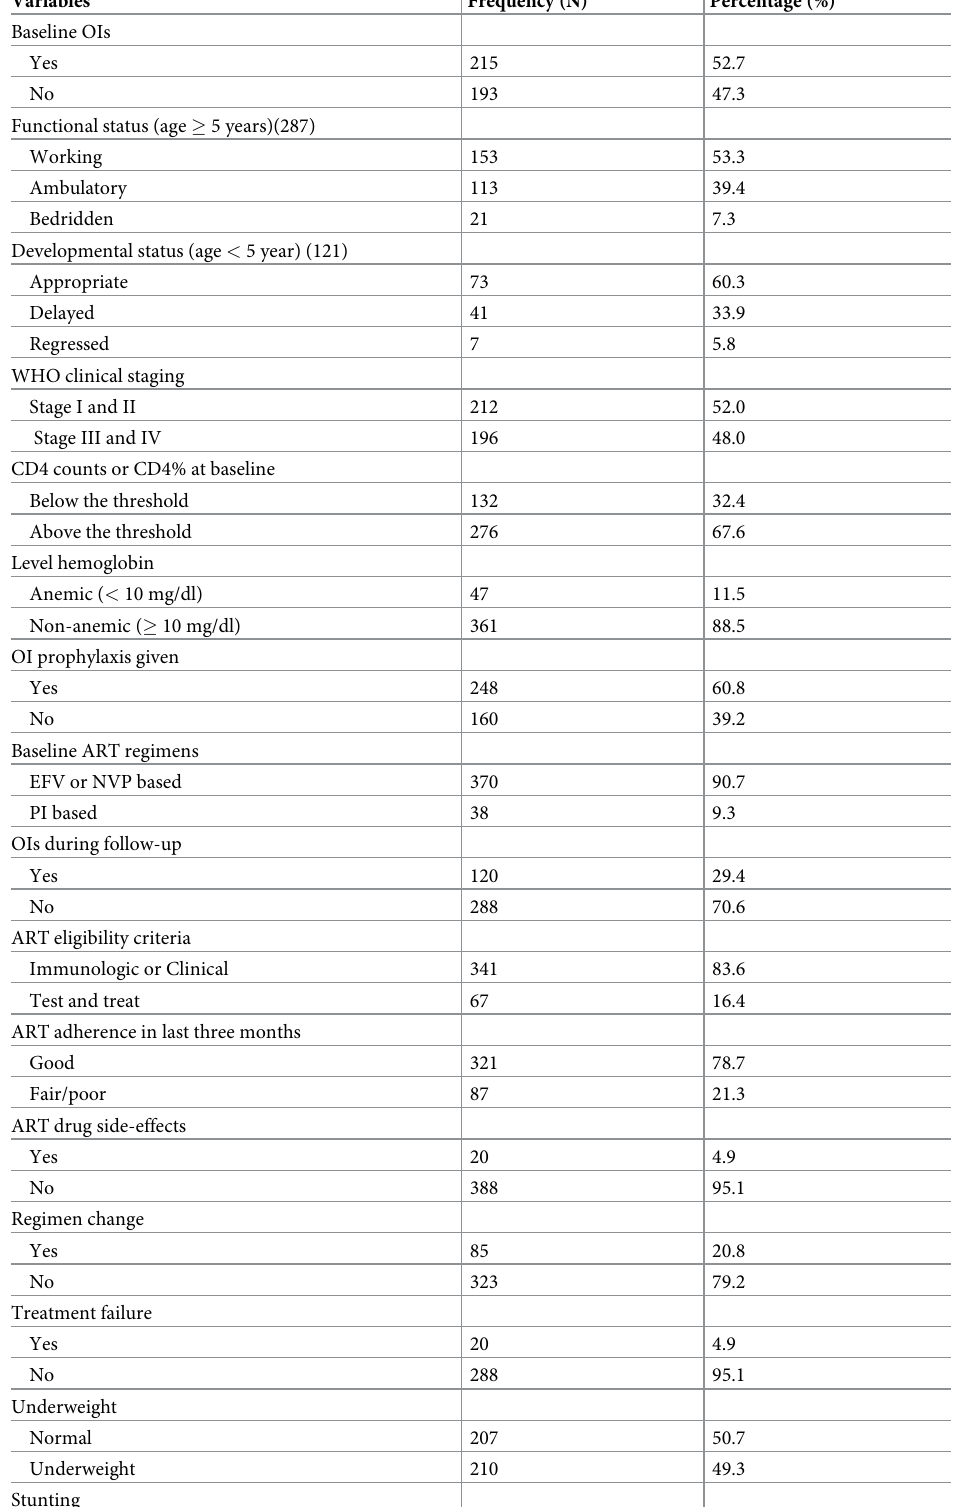
Table 2. Clinical, immunological, and nutritional characteristics of HIV infected children receiving ART at Debre-Markos Referral Hospital, Northwest Ethiopia,